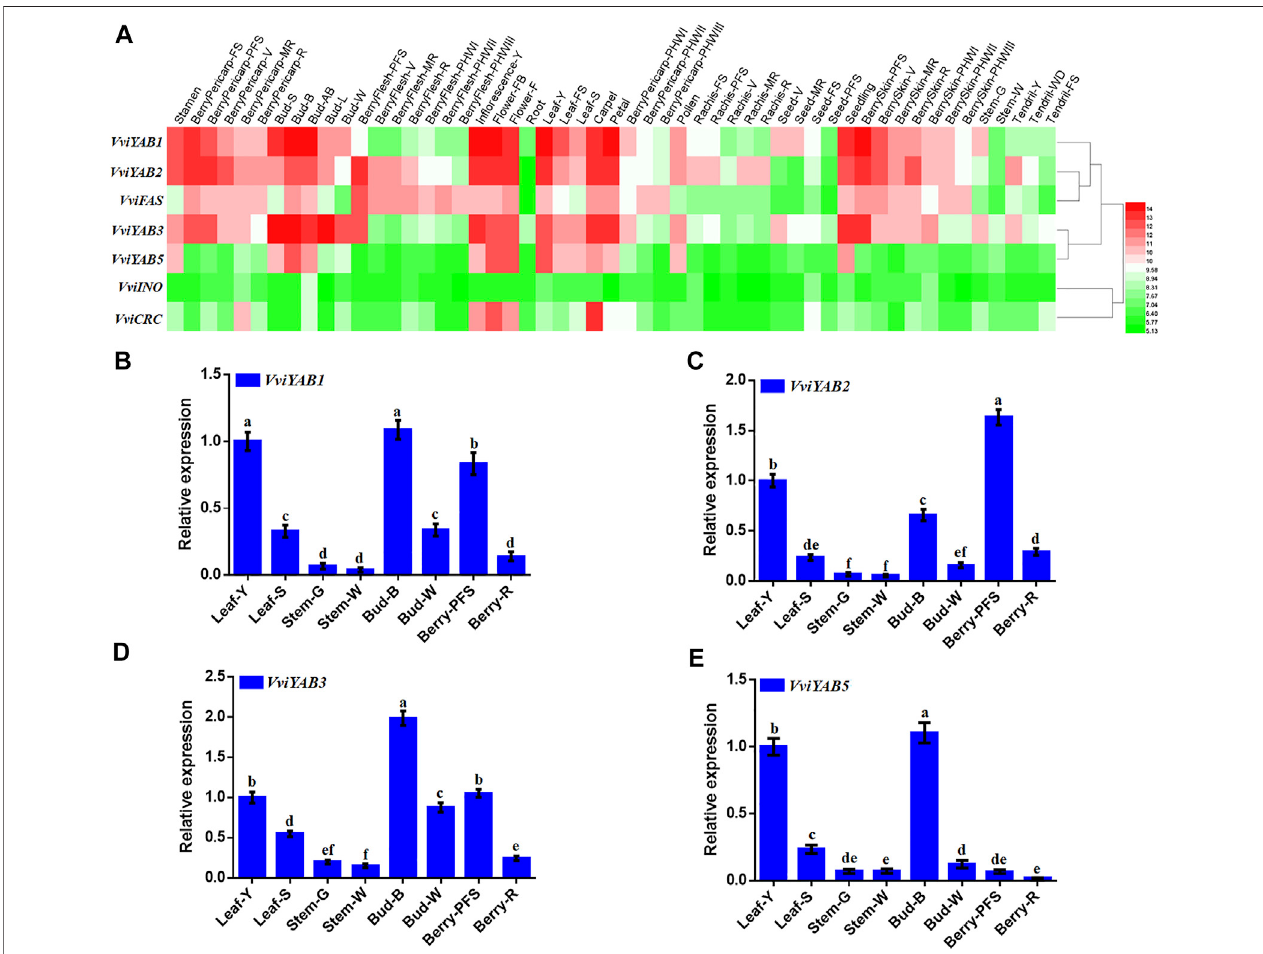
FIGURE 4 | Expression pro fi le of VviYABs in various tissues and developmental stages. (A) Expression of VviYABs in the V. vinifera cv “ Corvina ” atlas. Expression data were normalized based on the mean expression value of each gene in all analyzed tissues. Genes were hierarchically clustered based on average Pearson ’ s distance metric and “ average linkage ” method. Red and green boxes indicate high and low expression levels, respectively, for each gene. (B – E) qPCR validation of VviYAB geneexpressioninfourvegetative/greenandfourmature/woodyorgans,respectively.Transcriptswerenormalizedtotheexpressionofthe actin gene.The data are shown as means ± standard deviation (SD) of three replicates. Bud-AB, bud after burst; Bud-B, bud burst; Bud-W, winter bud; Bud-L, latent bud; Bud-S, bud swell; Flower-F, fl owering; Flower-FB, fl owering begins; FS, fruit set; In fl orescence-Y, young in fl orescence with single fl owers separated; In fl orescence-WD, well- developedin fl orescence;Leaf-FS,mature leaf; Leaf-S, senescingleaf; Leaf-Y,youngleaf; MR, mid-ripening; R, ripening; PFS,post fruit set;Stem-G, greenstem;Stem- W, woody stem; V,